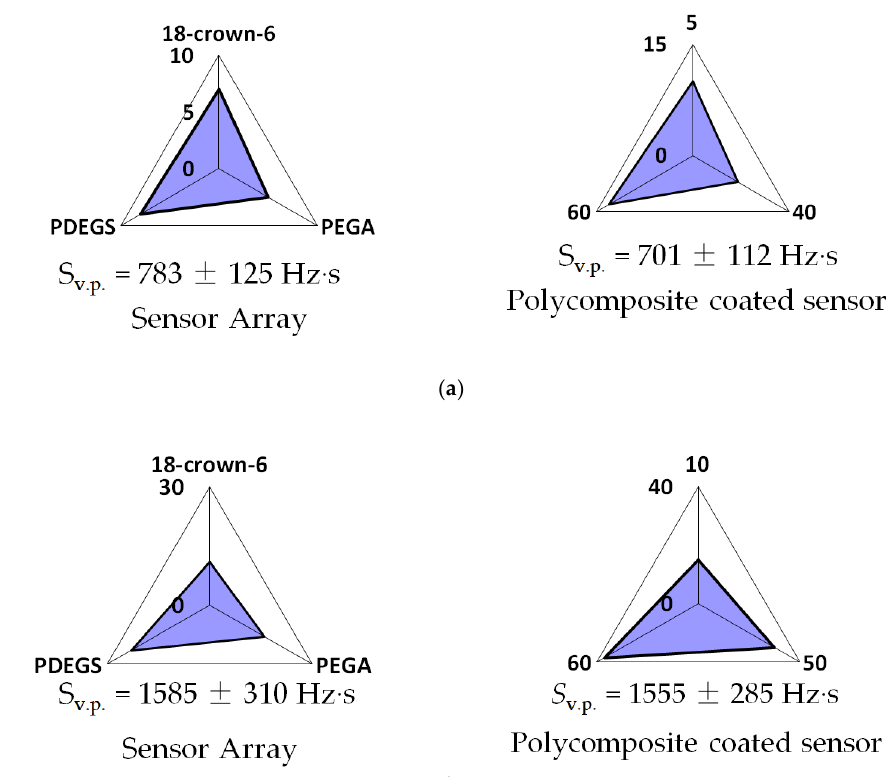
Figure 5. “Visual prints” by maximum signals for an array of sensors with individual coatings and considering the sorption kinetics for a sensor with a polycomposite coating during microweighing of vapors of 3-methylbutanoic acid ( a ) and ethanol ( b ). For an array of sensors, sorbents are marked in a circle; for a sensor with a polycomposite coating, the time of signal registration is marked.